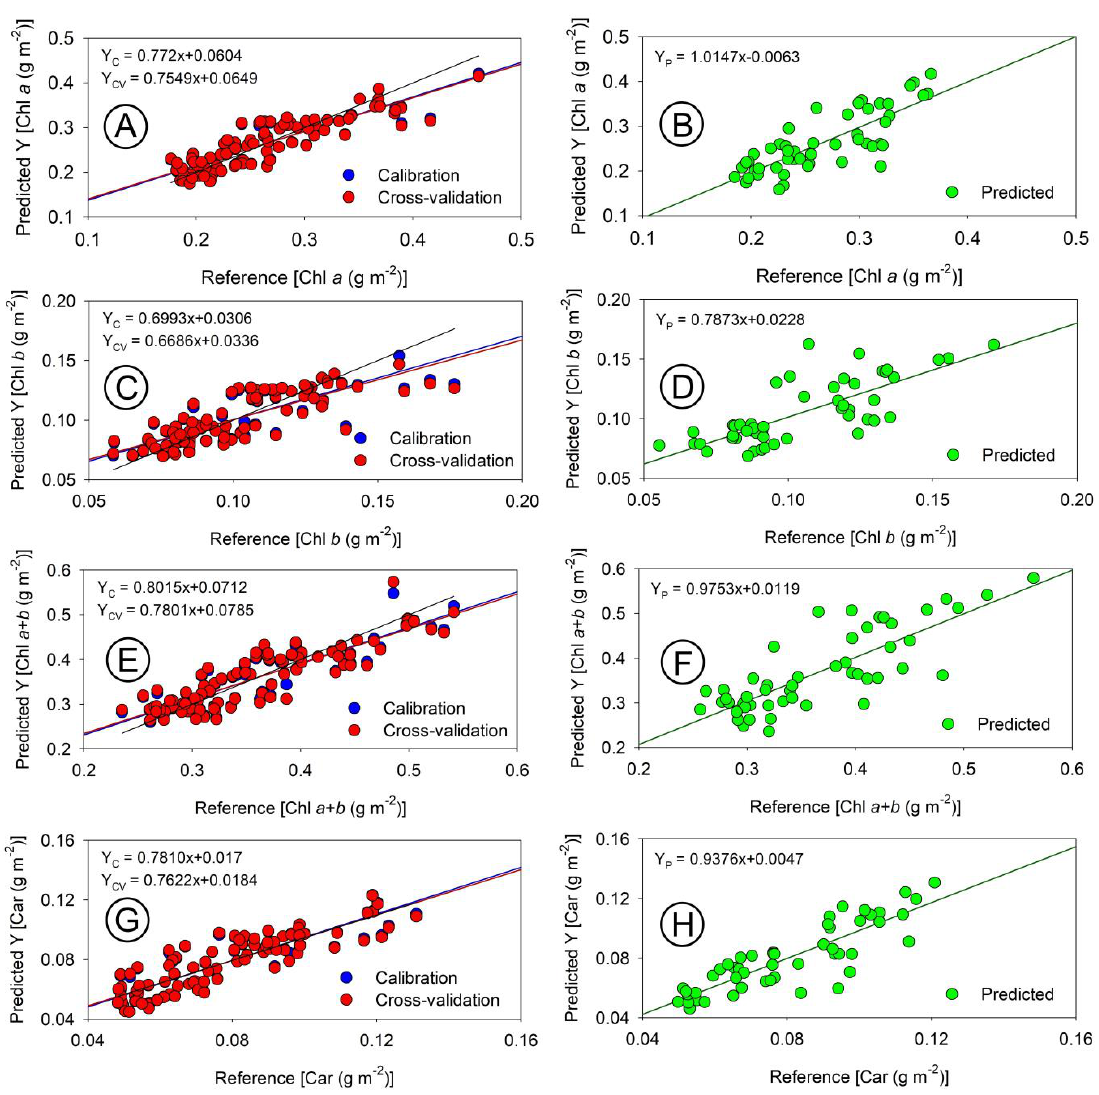
Figure 10. Scatterplot of models based on reflectance curves (400–700 nm) obtained with the spec- troradiometer. ( A , B ) chlorophyll a (Chl a ). ( C , D ) chlorophyll b (Chl b ). ( E , F ) chlorophyll total (Chl a + b ). ( G , H ) carotenoids (Car). Linear equation estimates were reported for calibration (Y C ; blue dots), cross-validation (Y CV ; red dots), and predicted (Y P ; green dots).